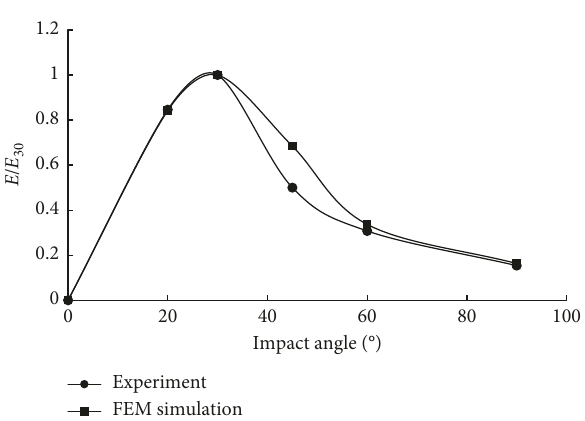
Figure 4: Change of the erosion rate with the impact angle.